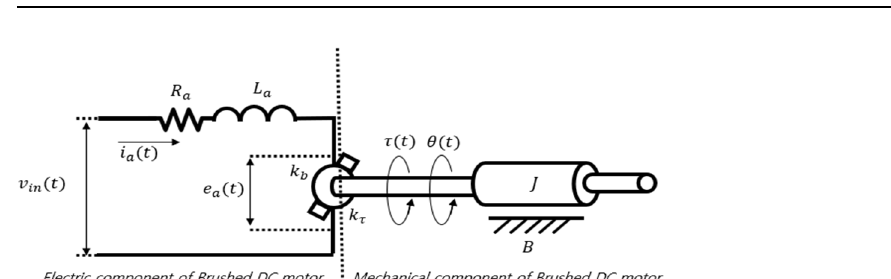
Figure 1. Schematic of a simplified equivalent representation of the brushed DC motor’s electrome- chanical components. Table 1. Names and symbols of electrical and mechanical elements.